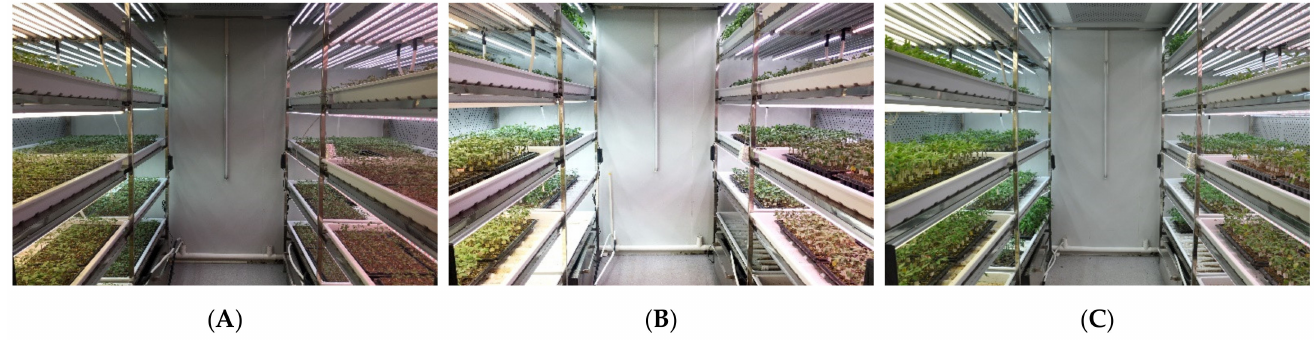
Figure 1. Tomato transplants at pre-grafting stage ( A ), healing stage ( B ), and post-healing stage ( C ). A total of 20 days after sowing the scion, the stem diameter of rootstock and scion was in the range between 2.0 mm and 3.0 mm. The grafting process was carried out manually by experienced workers using the cleft grafting method [2]. Air temperature in the growth chamber was maintained at 25 ◦ C ± 1 ◦ C and 20 ◦ C ± 1 ◦ C in photoperiod and dark period, respectively, and relative humidity was always controlled at 90% ± 5% within 7 days after grafting (in the healing stage). At pre-grafting and post-healing stage, air temperature and relative humidity in the growth chamber were maintained at 24 ◦ C ± 1 ◦ C and 60% ± 5%, respectively, in the light period, and 20 ◦ C ± 1 ◦ C and 65% ± 5%, respectively, in the dark period. During the whole seedling stage, the CO 2 concentration was maintained at 800 ± 50 µ mol mol − 1 in photoperiod and no control in the dark